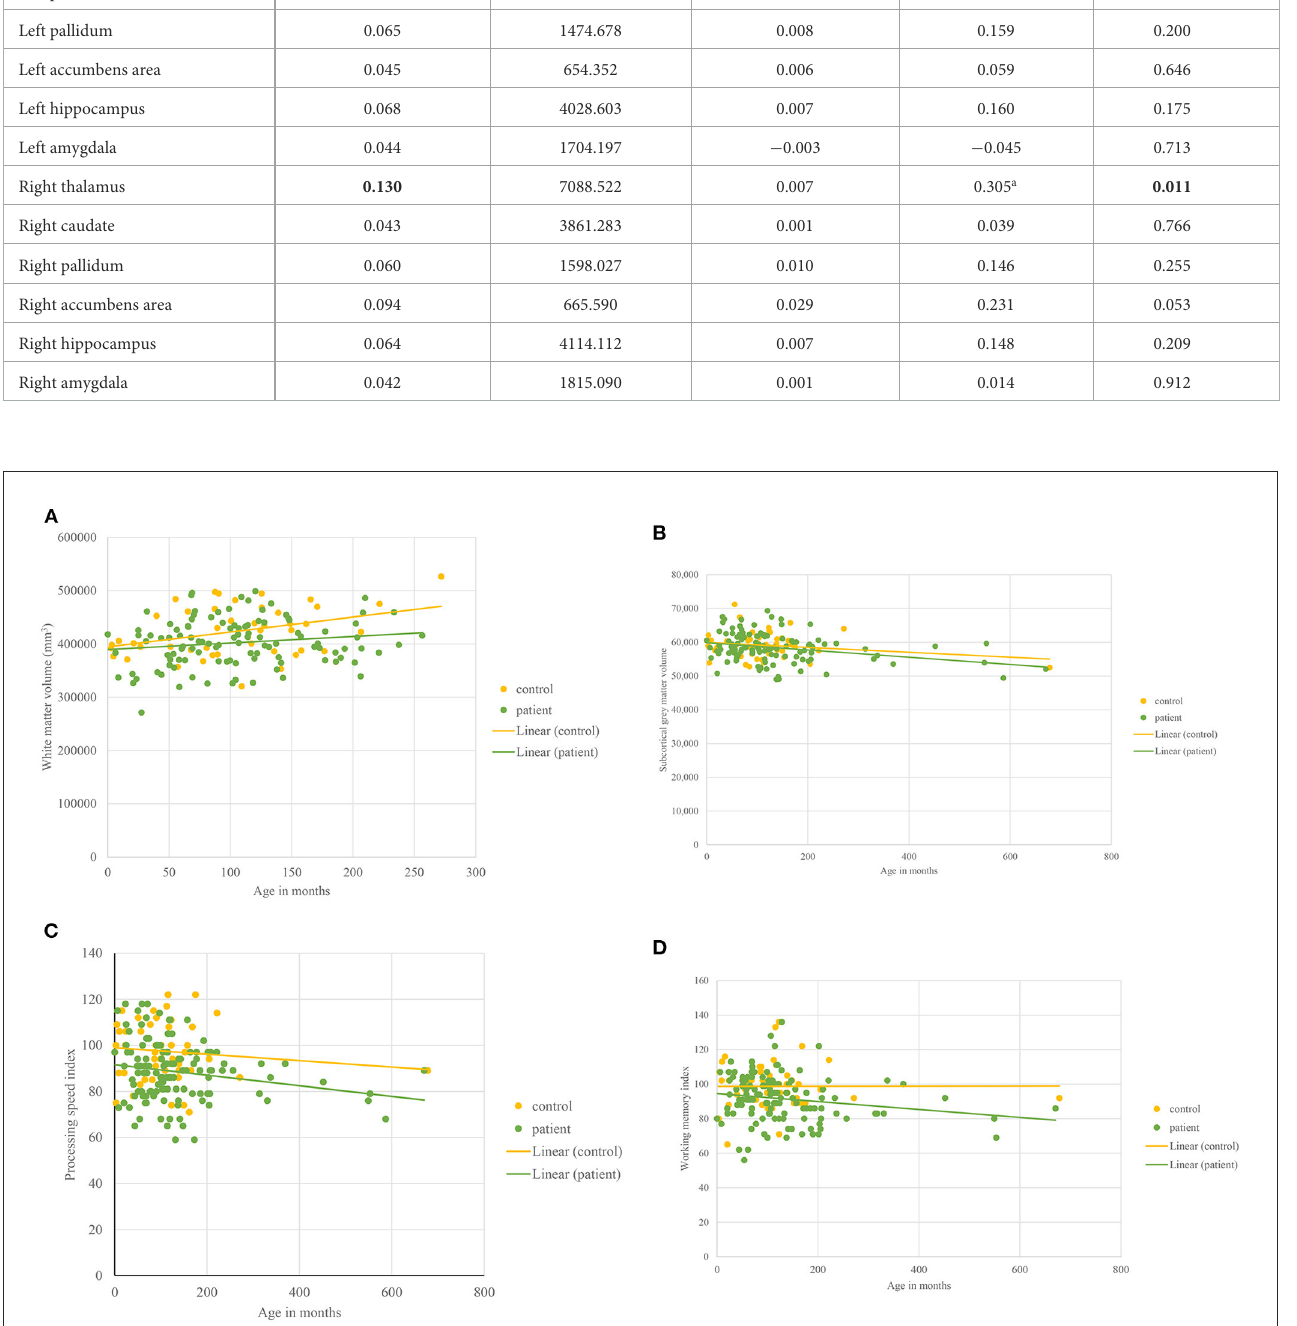
FIGURE2 Developmental trajectories. For all figures, 0 denotes 8 years of age as it represents the earliest age at which data were collected. (A) White matter volume plotted against Age in patients with sickle cell disease and controls aged < 30 years. (B) Total subcortical volume plotted against Age in patients with sickle cell disease and controls. (C) Processing speed index plotted against Age in patients with sickle cell disease and controls. (D) Working memory Index plotted against Age in patients with sickle cell disease and